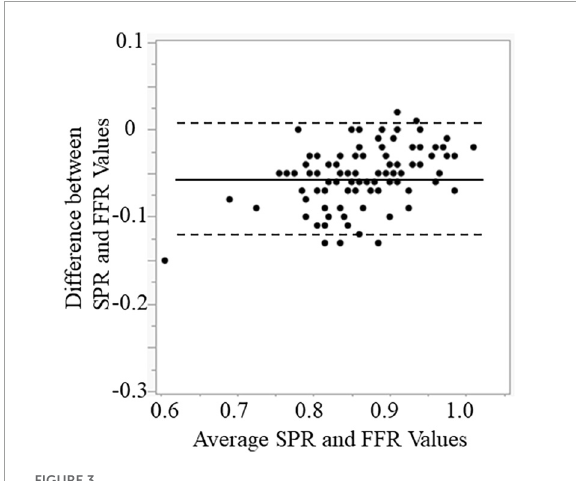
FIGURE3 Bland–Altman plots showing agreement between SPR and FFR. SPR, saline-induced Pd/Pa ratio; FFR, fractional flow